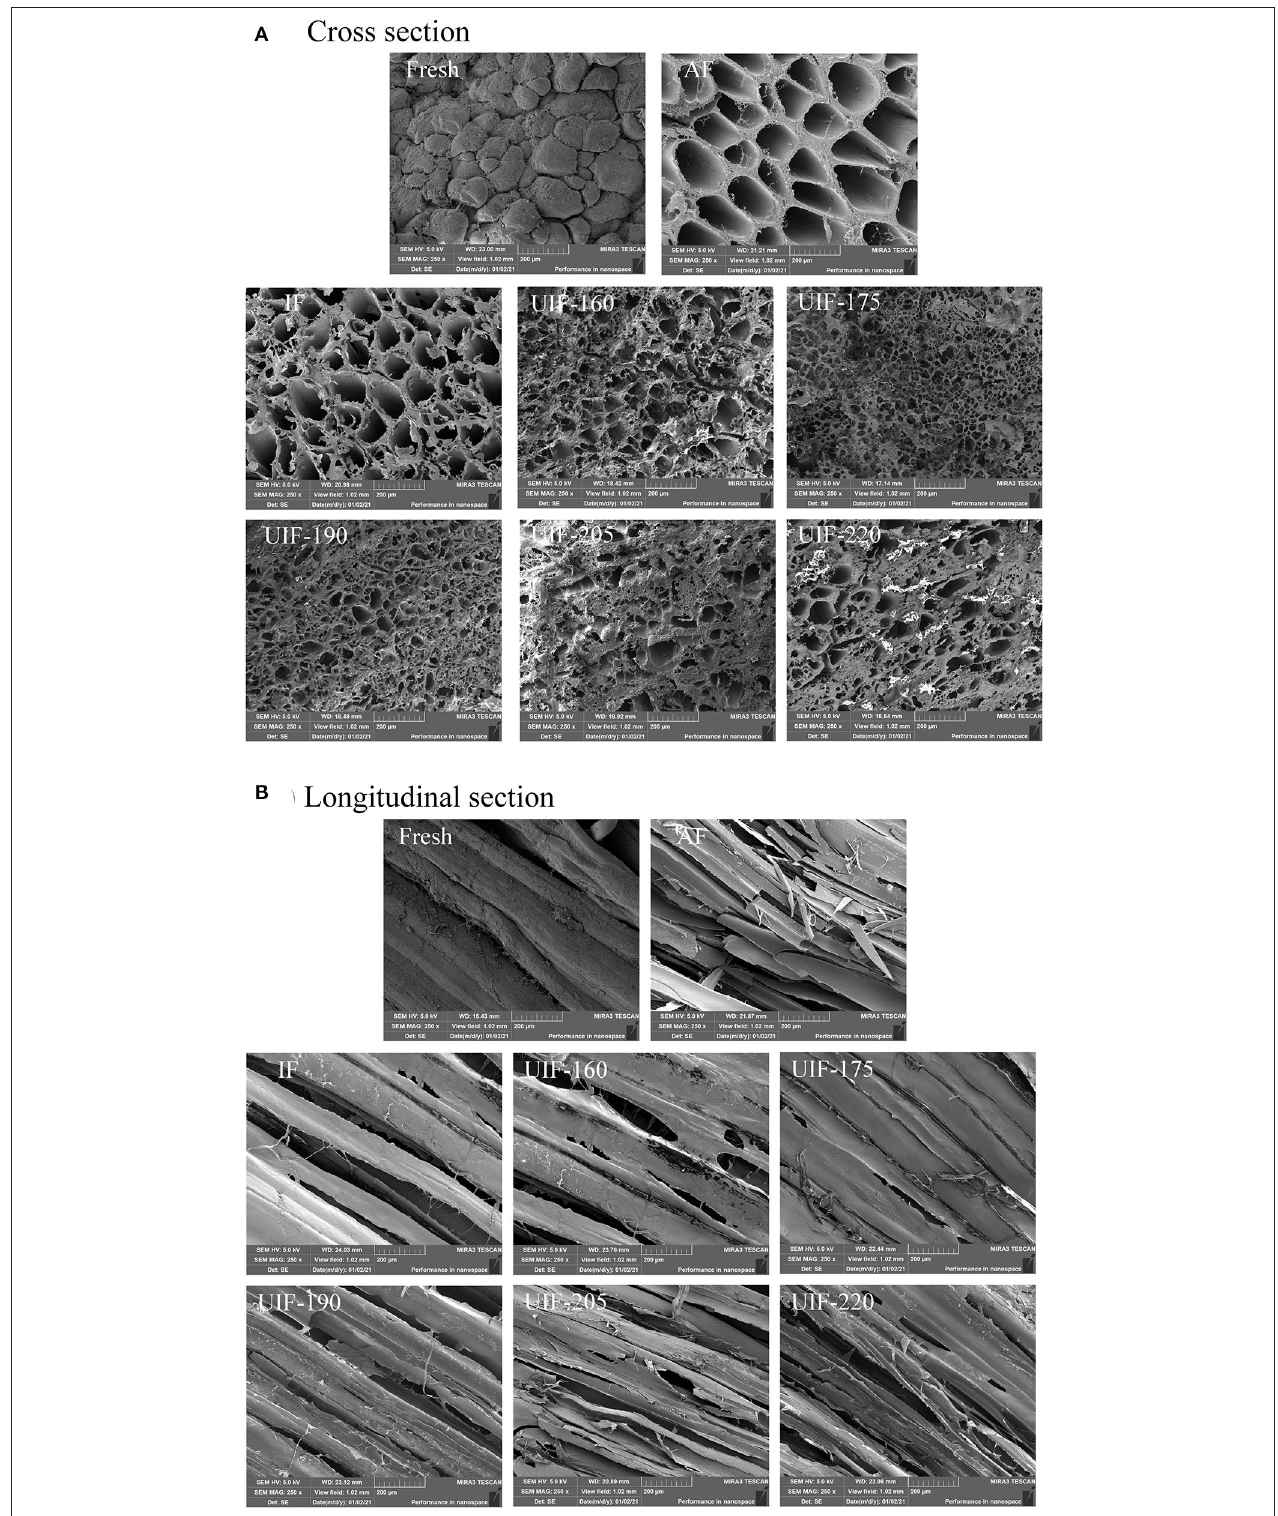
FIGURE 4 | Influence of different freezing treatments on the microstructure of the large yellow croaker. (A) Cross section and (B) Longitudinal section.